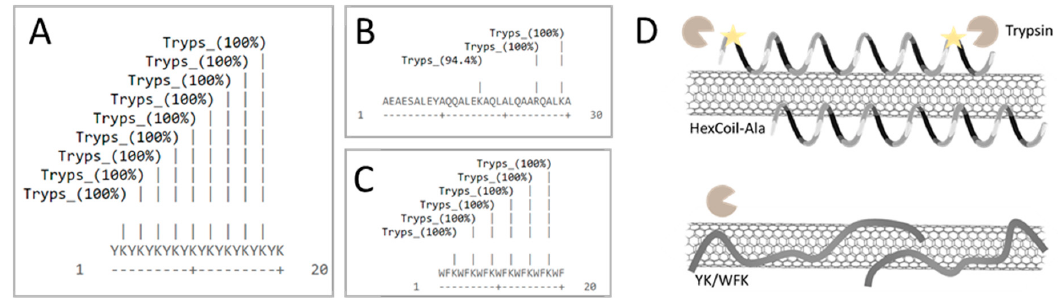
Figure 4. A map of the trypsin restriction sites on ( A ) YK, ( B ) HexCoil-Ala, and ( C ) WFK. ( D ) Schematic presentation of possible mechanisms that could account for the lack of trypsin reaction of YK and WFK sensors.